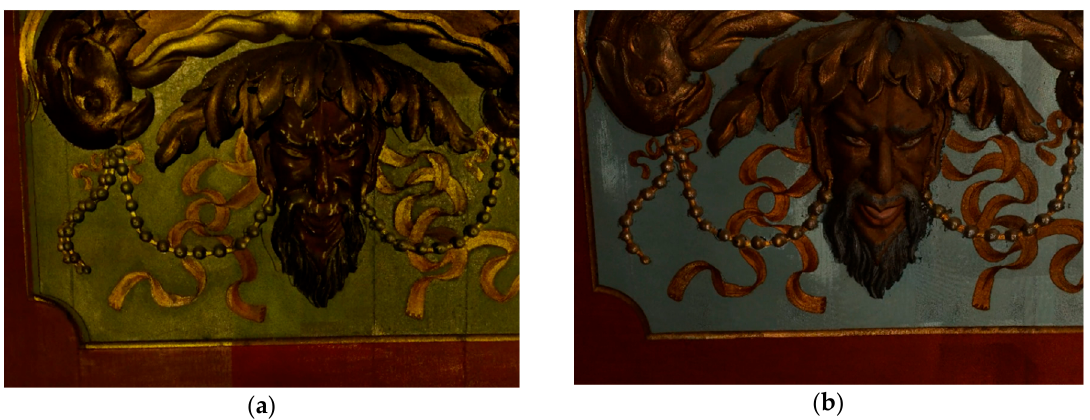
Figure 1. Visual comparison between two registered point clouds of the King’s Chinese Cabinet: ( a ) from 2009 and ( b ) from 2015.